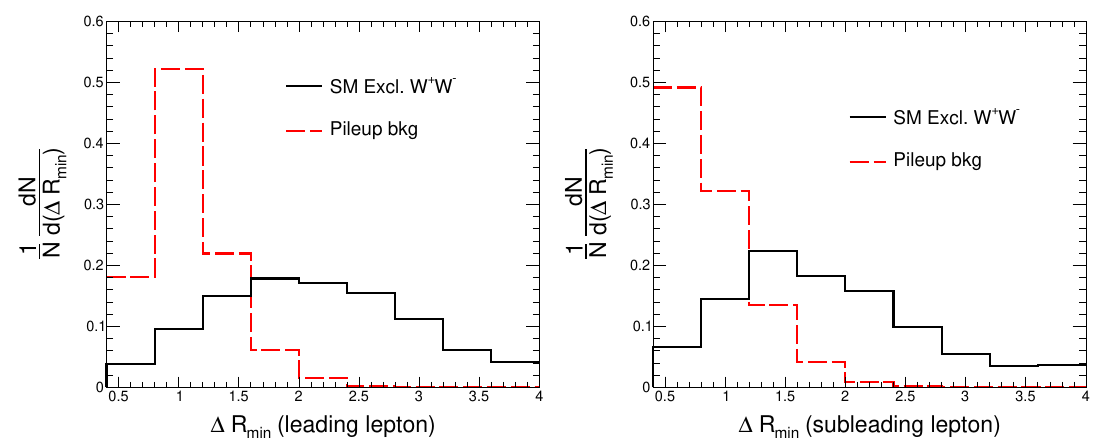
Figure 7 . Separation in y - φ space between the isolated leptons and the closest particle, p ∆ R min = (∆ y ) 2 + (∆ φ ) 2 , for exclusive W + W − (black full line) and pileup background (red dashed line) for leading p T lepton (left), and subleading- p T when p T > 25 GeV, for W + W − purely leptonic decay channel. The distributions are normalized to